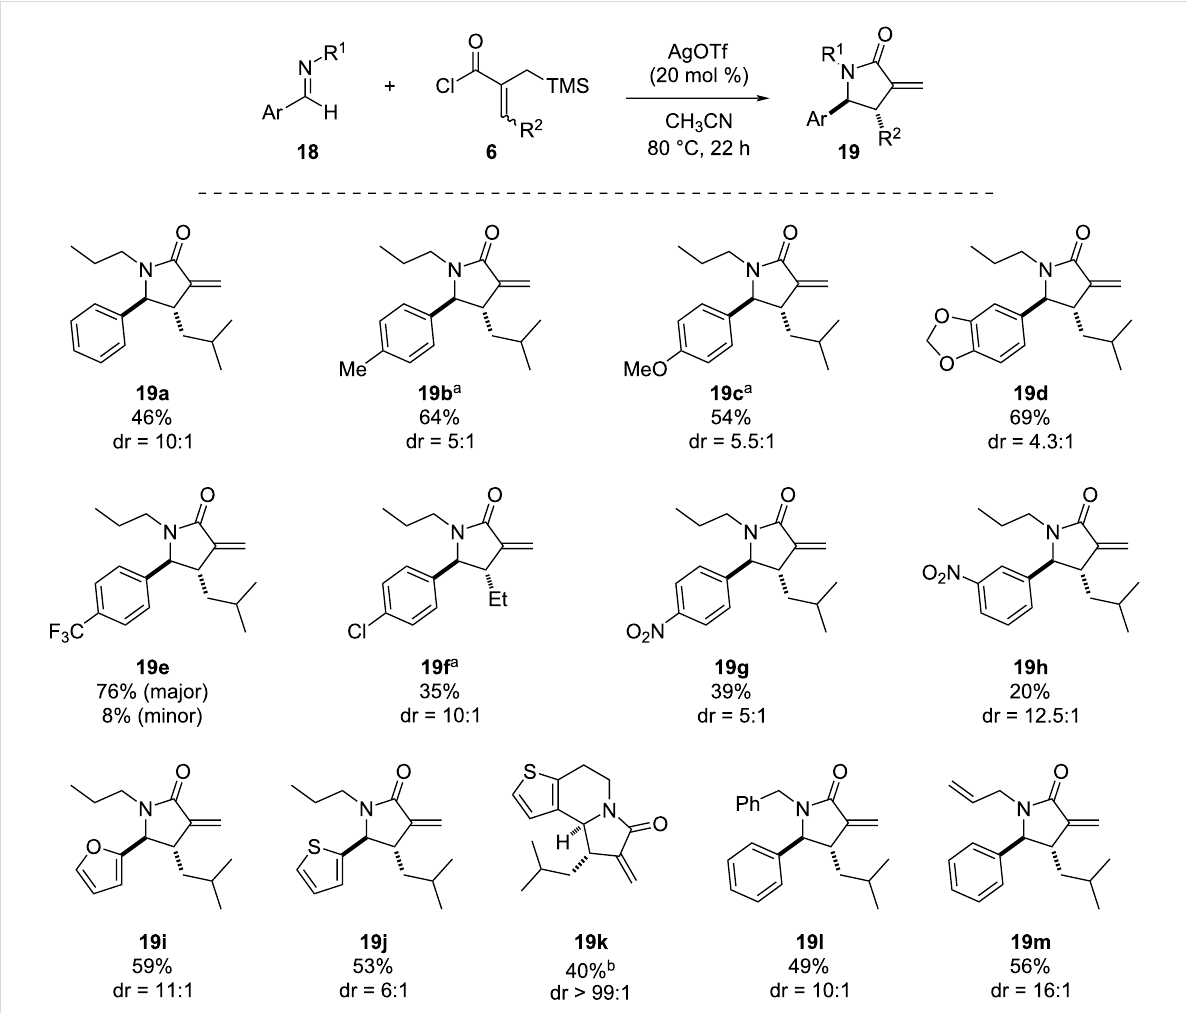
Scheme 3: Scope of the aza-Nazarov cyclization with acyclic imines. a The syntheses of aza-Nazarov products 19b , 19c , and 19f were described pre- viously [35]. b The reaction was carried out at 23 °C in CH 2 Cl 2 using 1.3 equiv of